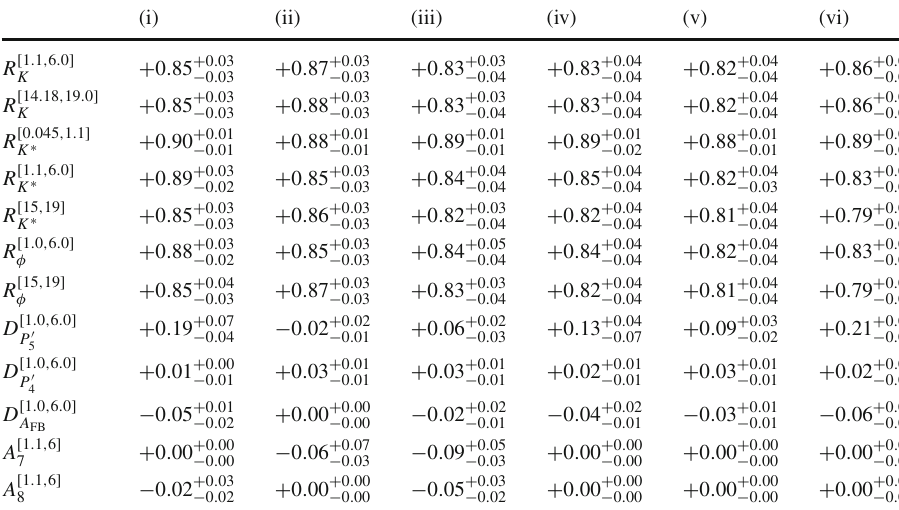
Fig. 10 show the CP Asymmetries in the scenarios with